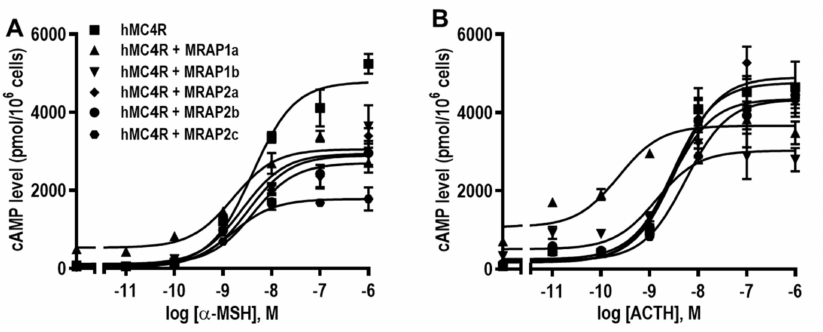
Figure 7. The signaling properties of hMC4R are regulated by hMRAP1s or hMRAP2s in response to α -MSH ( A ) and ACTH ( B ). HEK293T cells were transiently transfected hMC4R with or without MRAP1a, MRAP1b, MRAP2a, MRAP2b or MRAP2c plasmids (1:5), and intracellular cAMP levels were measured by RIA after stimulation with different concentrations of α -MSH or ACTH(1–24). Data are mean ± SEM from triplicate measurements within one experiment. All experiments were performed at least three times